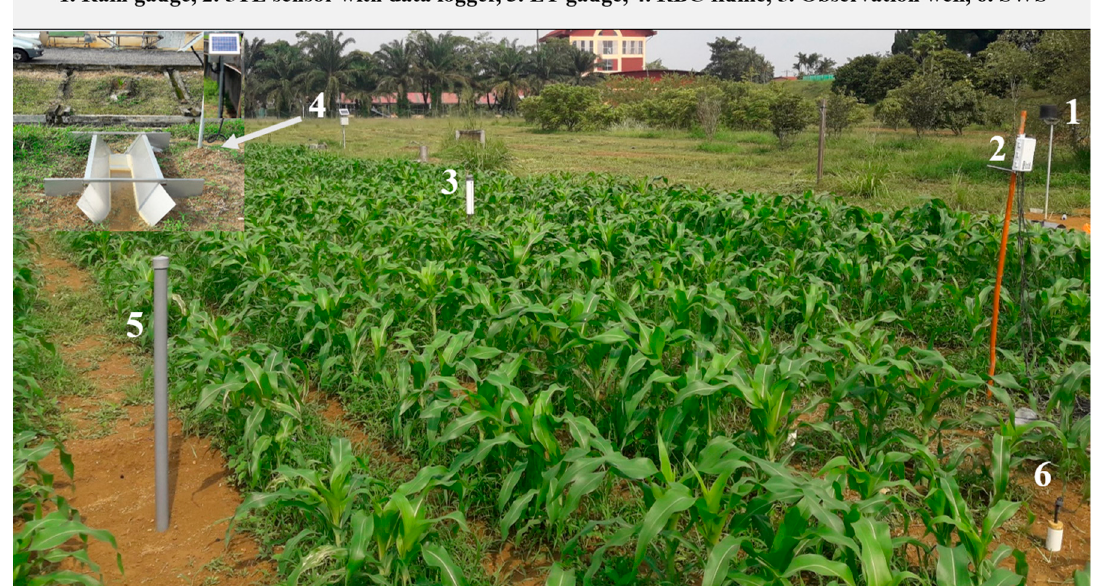
Figure 2. A view of the installation of different equipment in the field.